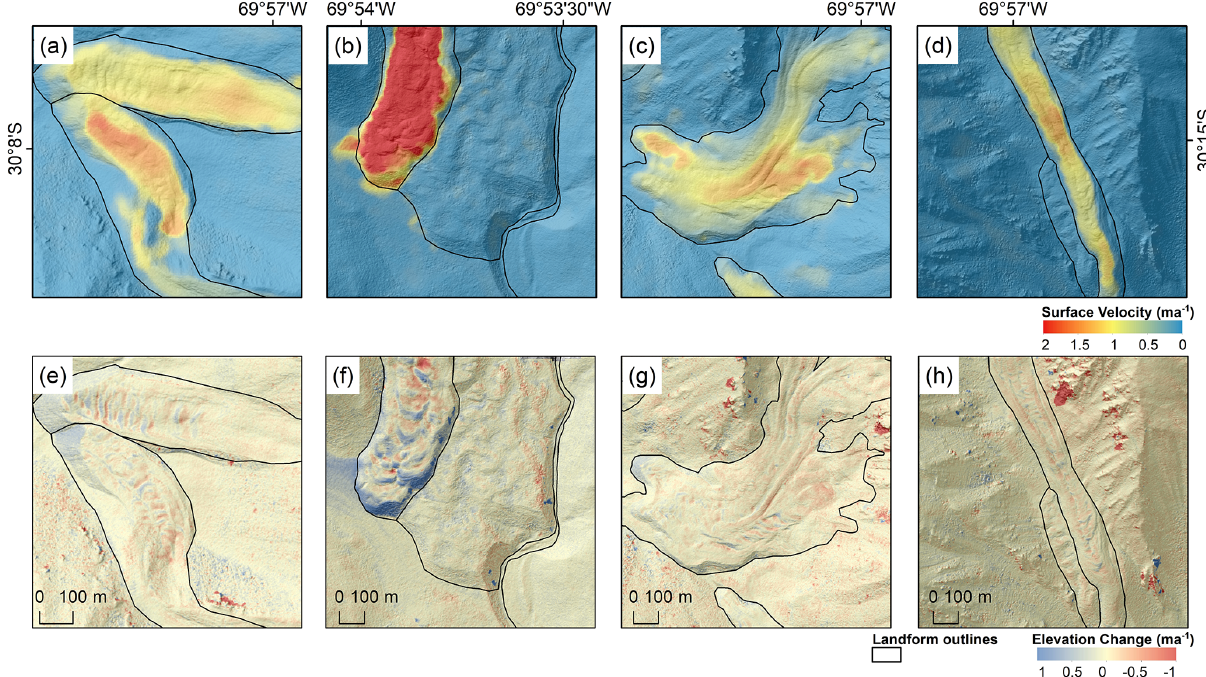
Figure 6. Mean annual surface velocities and surface elevation changes between 2012 and 2020 for four select ice-debris landforms. The landforms shown are CL104301020A and CL104301020B (in panels a and e ), CL104300054 (shown in panels b and f ), CL104301021 (shown in panels c and g ), and Llano de Las Liebres (CL104300007) (shown in panels d and h ).